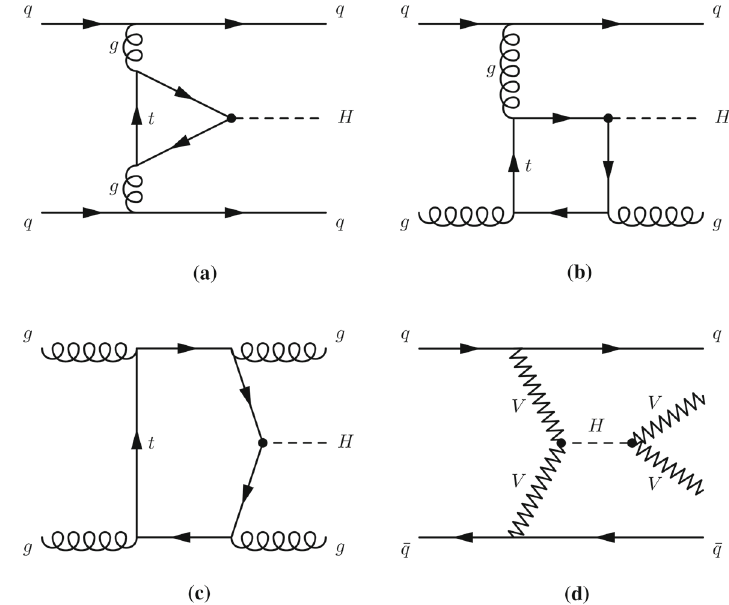
Fig. 1 Examples of Feynman diagrams contributing to the production of a Higgs boson in association with two jets via the fusion of two gluons or two vector bosons ( V ) at leading order in QCD. The presented diagrams show examples for the subprocesses a qq → Hqq , b qg → Hqg and c gg → Hgg , as well as d the vector-boson fusion process and the subsequent decay of the Higgs boson into two vector